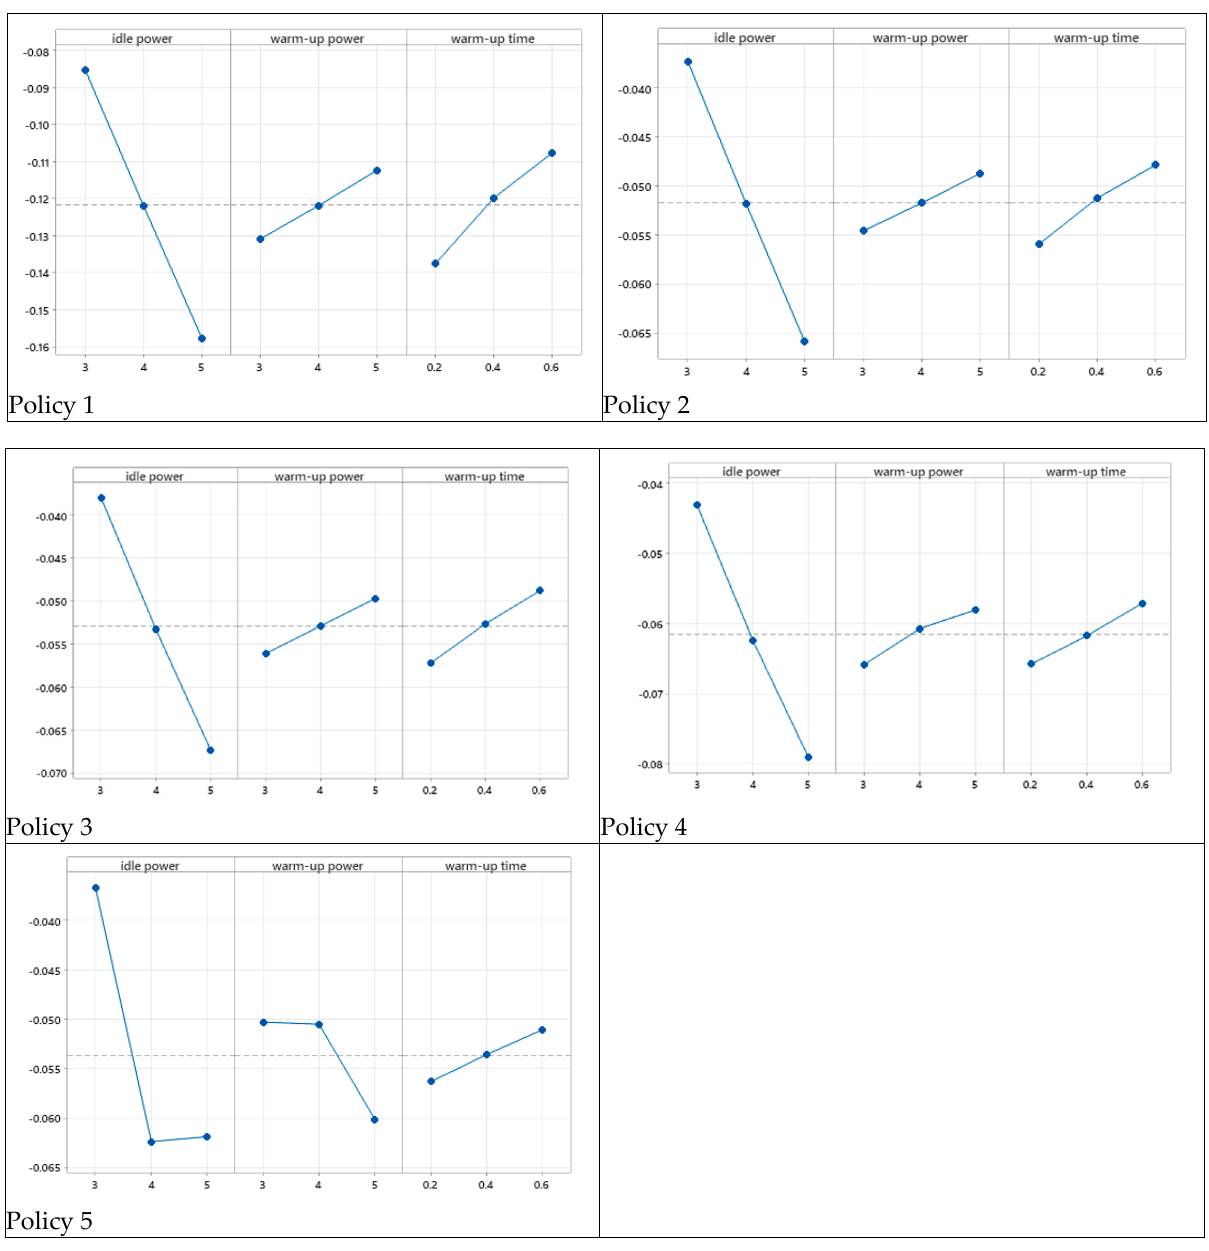
Figure 3. Main e ff ects.